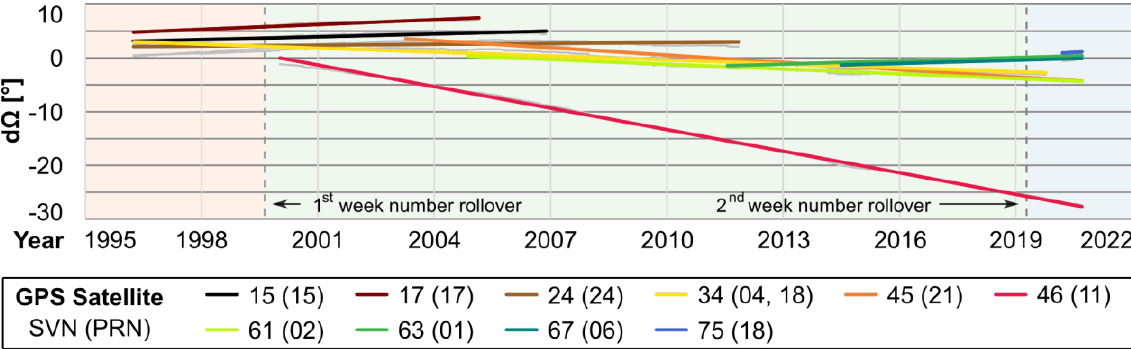
Figure 6. The trend of separation of satellite ANs from OP D.